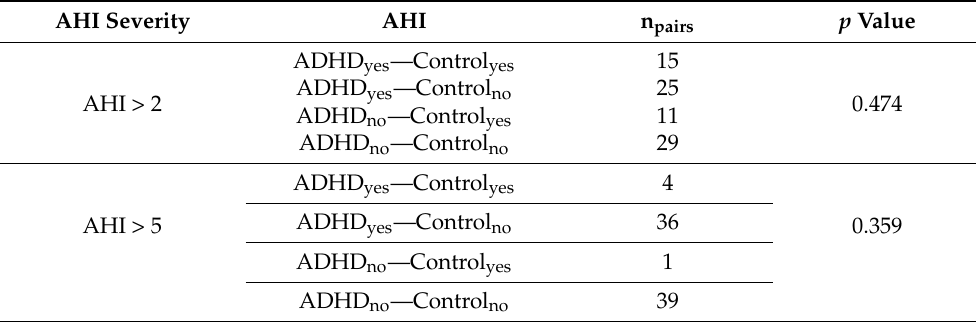
Table 12. Comparison of number of AHI values between ADHD and control